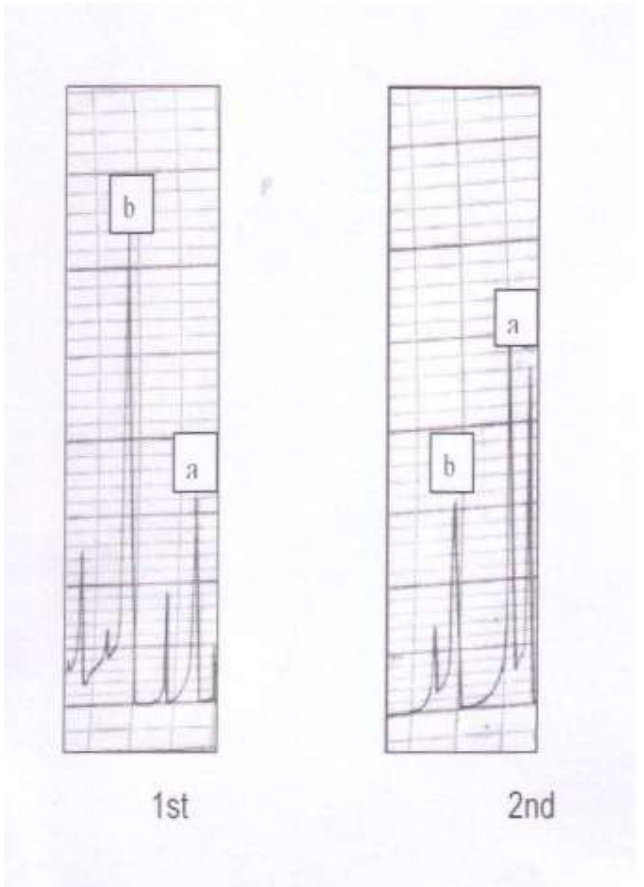
Figure (2): HPLC separation of gingerol. Peak (a) gingerol in acetone. Peak (b) is phenol, added as internal standard. The column packed with Nucleosil C18 was used and acetone: chloroform;water (pH 5.8) as mobile phase UV detector 455 nm. Flow rate 2.6 ml/min. The retention time was (6)